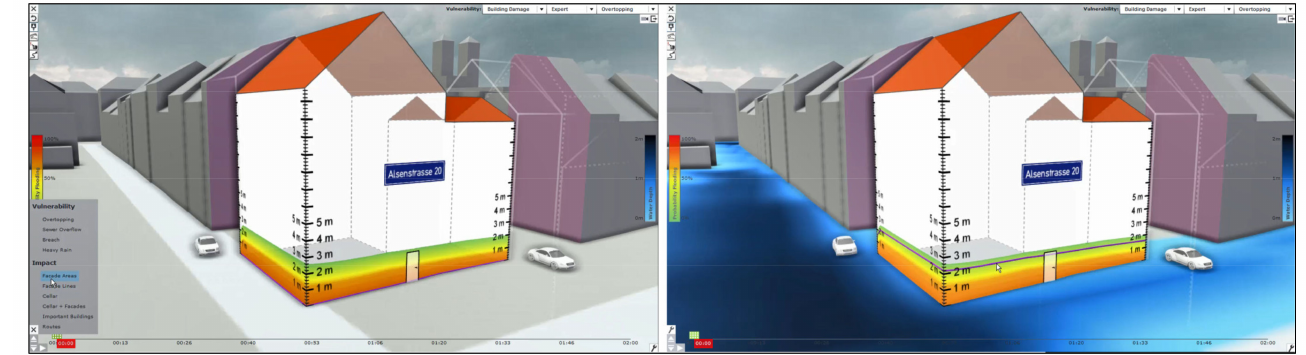
Figure 15. Probability of a particular part of the building façade to be exposed to water: selection of the desired impact visualization and scenario ( left ); selection of a sample scenario from the entire scenario ensemble directly from the building façade ( right ). The colors denote a range from 0% probability (green) to a 100% probability (red).